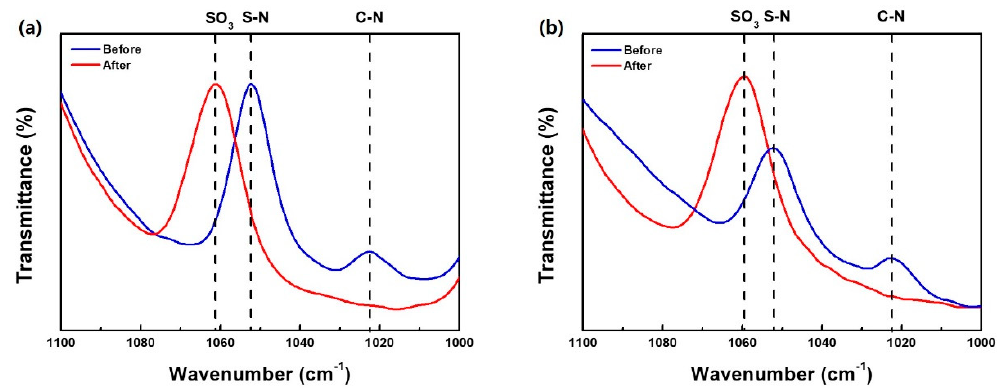
Figure 7. FT-IR spectra of the ( a ) Nafion-TMA and ( b ) Aquivion-TMA membranes before and after the alkaline stability test.